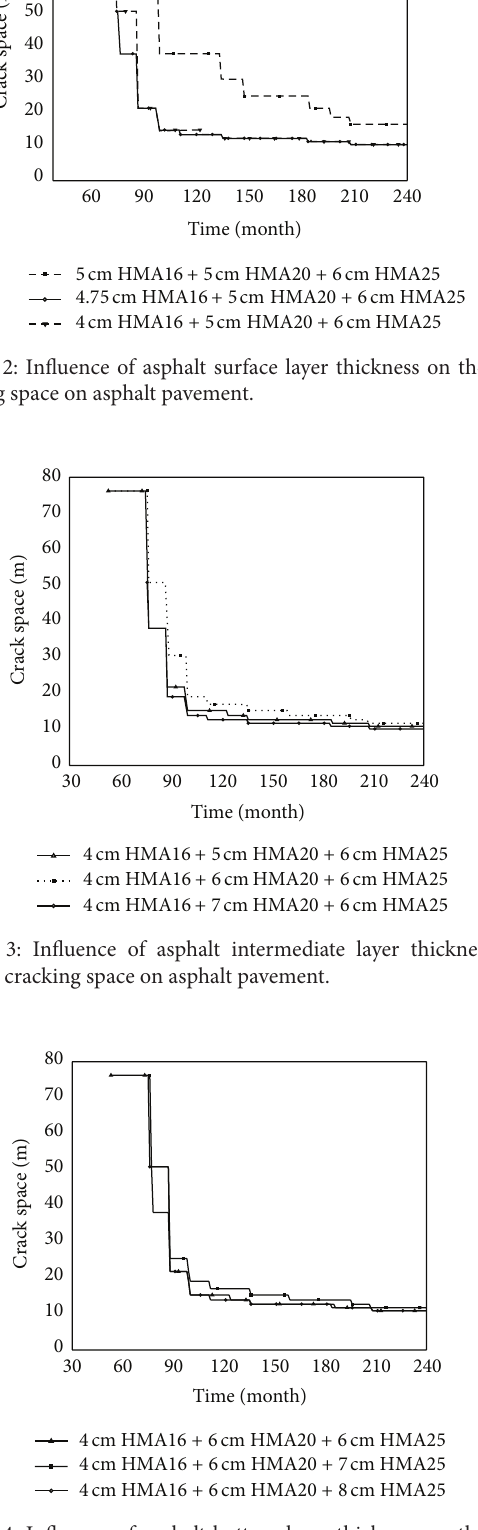
Figure 4: Influence of asphalt bottom layer thickness on thermal cracking space on asphalt pavement.